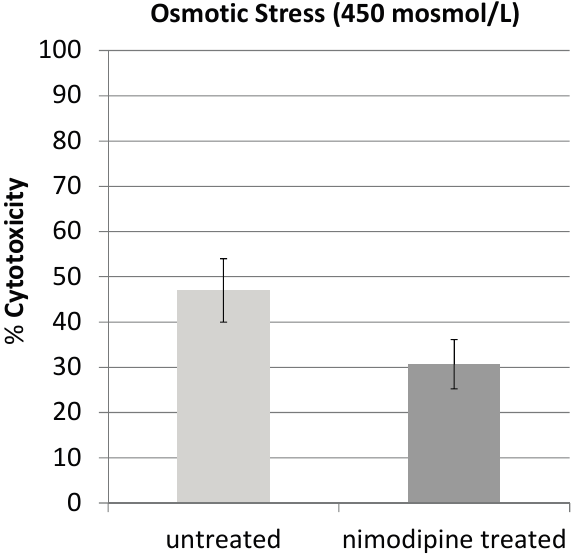
Figure 3. PC12 cells were treated with additional NaCl (450 mosmol/L) and 20 µM nimodipine or DMSO and incubated for 48 h. The osmotic stress induced cytotoxicity of 47% in the untreated PC12 was reduced to 30.7% cytotoxicity in nimodipine-treated cultures.